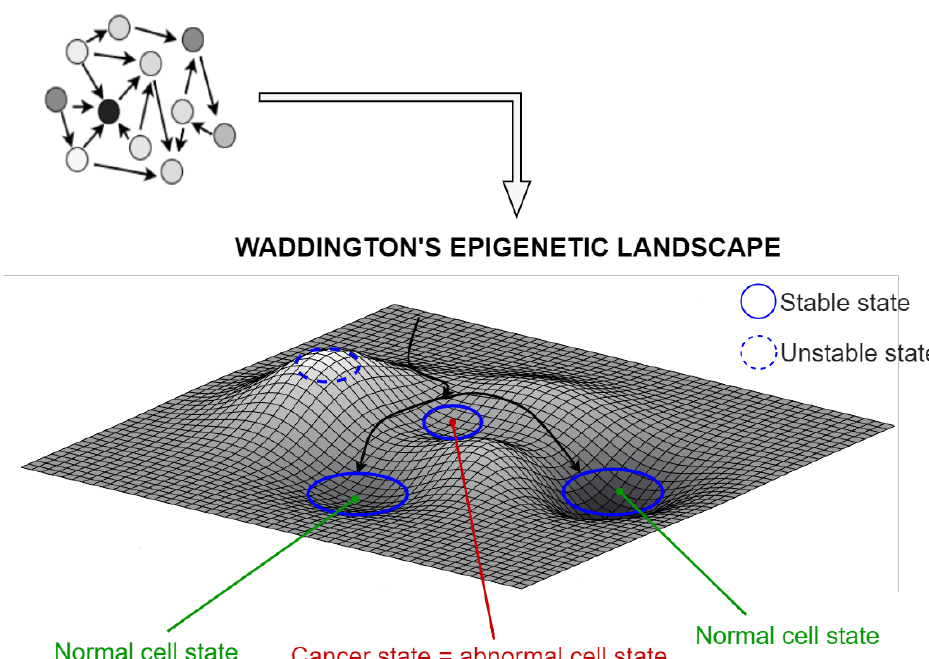
Figure 1. Representation of Waddington’s epigenetic landscape. The landscape is depicted with random morphology aimed at merely exemplifying purposes. Each point in the epigenetic landscape represents a state of the genetic network, defined by the expression levels of each one of the genes constituting the network. Changes in gene expression can lead to shifts in the epigenetic landscape. As the network’s collective expression pattern changes, the point defining its state shifts through the landscape until settling down into a new equilibrium state. Examples of the network state’s time evolution are depicted with black arrows. Stable equilibrium states, corresponding to valleys, are highlighted with blue solid circles, whereas unstable equilibrium states, associated to hills, are highlighted with blue dashed circles. Both normal cell states (highlighted with green circles) and abnormal cancer cell states (indicated with red circles) can be found among stable equilibrium